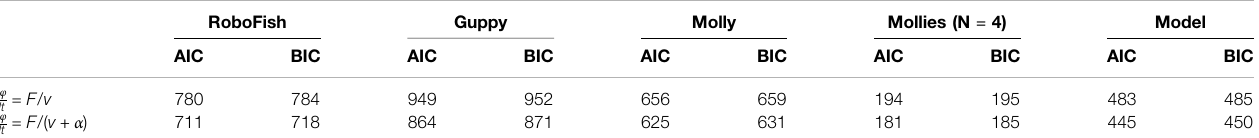
TABLE 3| Statistical model comparison. Akaike (AIC) and Baysian (BIC) information criterion for amodel without ( d φ model-species. Forthesame experimental data,themodelwiththesmaller AICorBIC ispreferable,wherebytheBIC penalizesadditionalparametersstronger and thus is more conservative. The values of the parameters α and F are listed in Supplementary Table S4 .